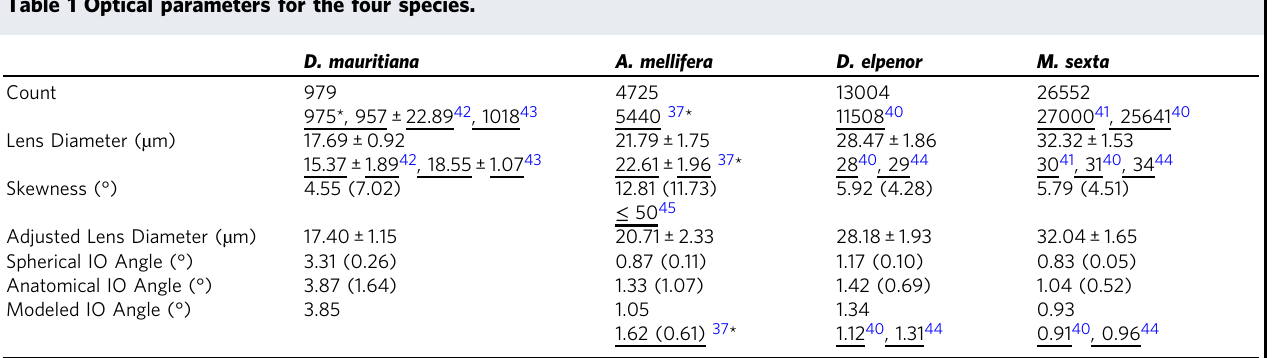
Values are mean ± s.d except for angular measurements, which show median (IQR). Comparable measurements from the literature or measured manually are underscored below corresponding values, with an asterisk indicating manual measurements of the same